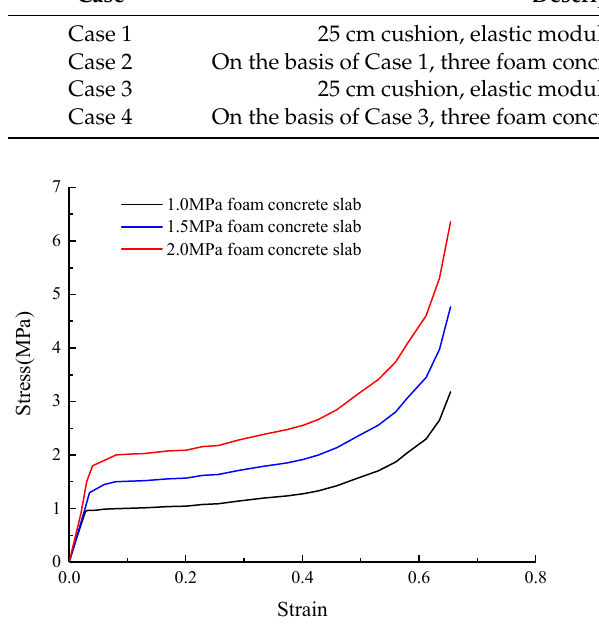
Figure 13. Stress-strain curves of three foam concrete slabs.